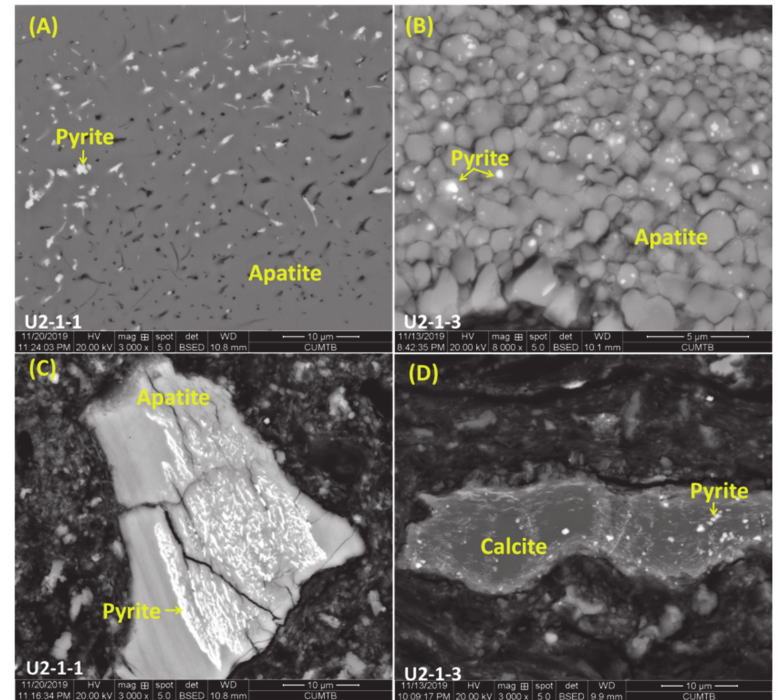
Figure 8. Backscattered electron images of pyrite that co-exists with apatite and calcite in OS2 oil shales. ( A ) Pyrite fills a cavity within apatite; ( B ) fine pyrite crystals scattered among apatite particles; ( C ) small pyrite grains dispersed over a large apatite grain; ( D ) small pyrite grains on the surface of a large calcite grain.